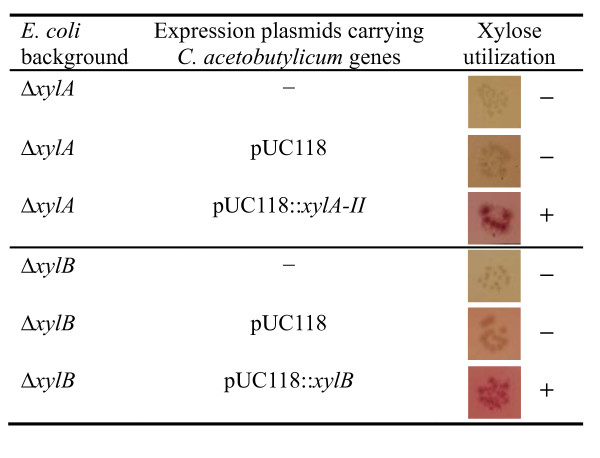
Complementation of E. coli mutants deficient in xylose isomerase or xylulokinase by C. acetobutylicum genes. The empty vector was expressed in the same strain as a negative control. The ability of xylose utilization was tested using MacConkey agar supplemented with 10 g l-1 xylose. The colonies of cells with the ability in xylose utilization showed red color, whereas the colonies of cells unable to utilize xylose keep yellow.